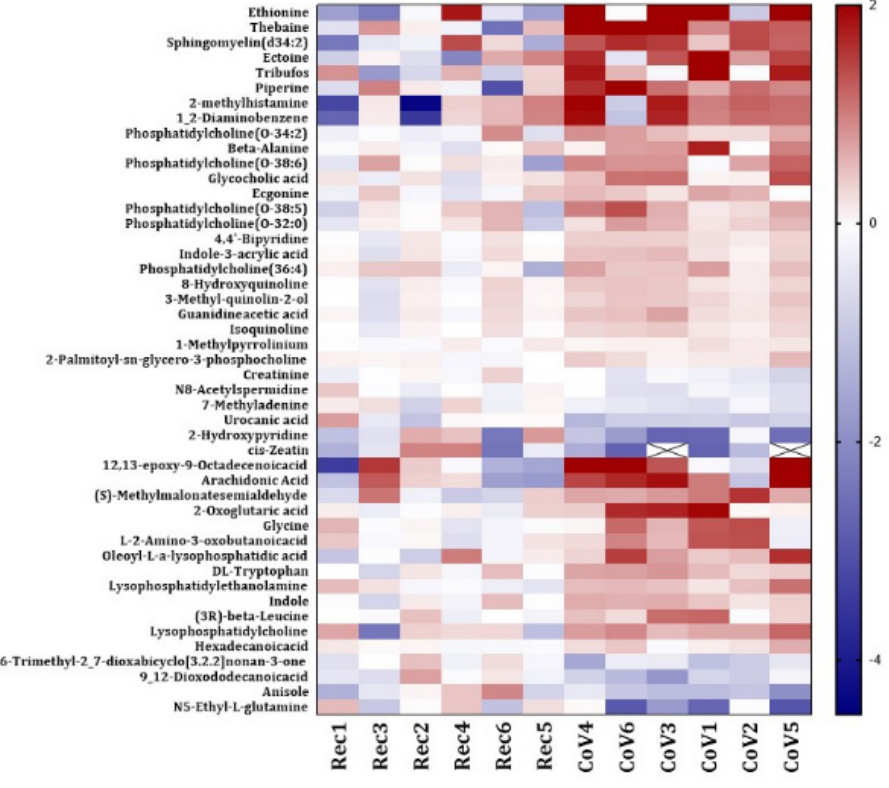
Figure 4. Heat map showing differential levels of serum metabolites in COVID-19-positive and COVID-19-recovered patients. The fold changes of the normalized abundances of various metabolites found in the serum samples from COVID-19-positive (CoV) and COVID-19-recovered (Rec) patients were calculated and the metabolite levels that were significantly altered were represented as a heatmap. The fold changes are color coded in the heat map, with red representing a positive fold change (increase) and blue representing a negative fold change (decrease). For several samples, the fold change values were below the ranges specified in the heat map. These values are represented with a cross